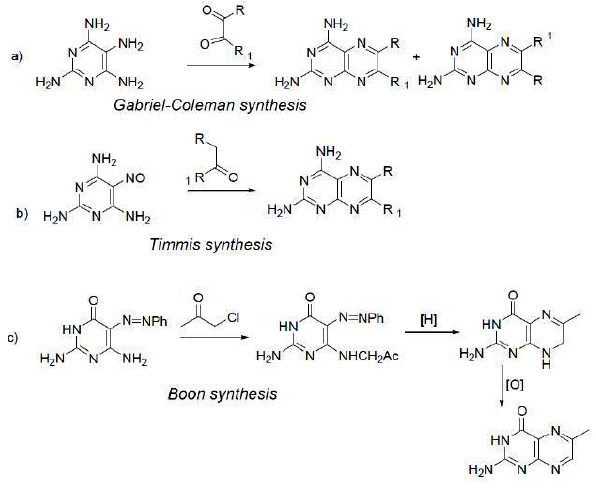
Figure 13: Different synthetic routes of pterins.